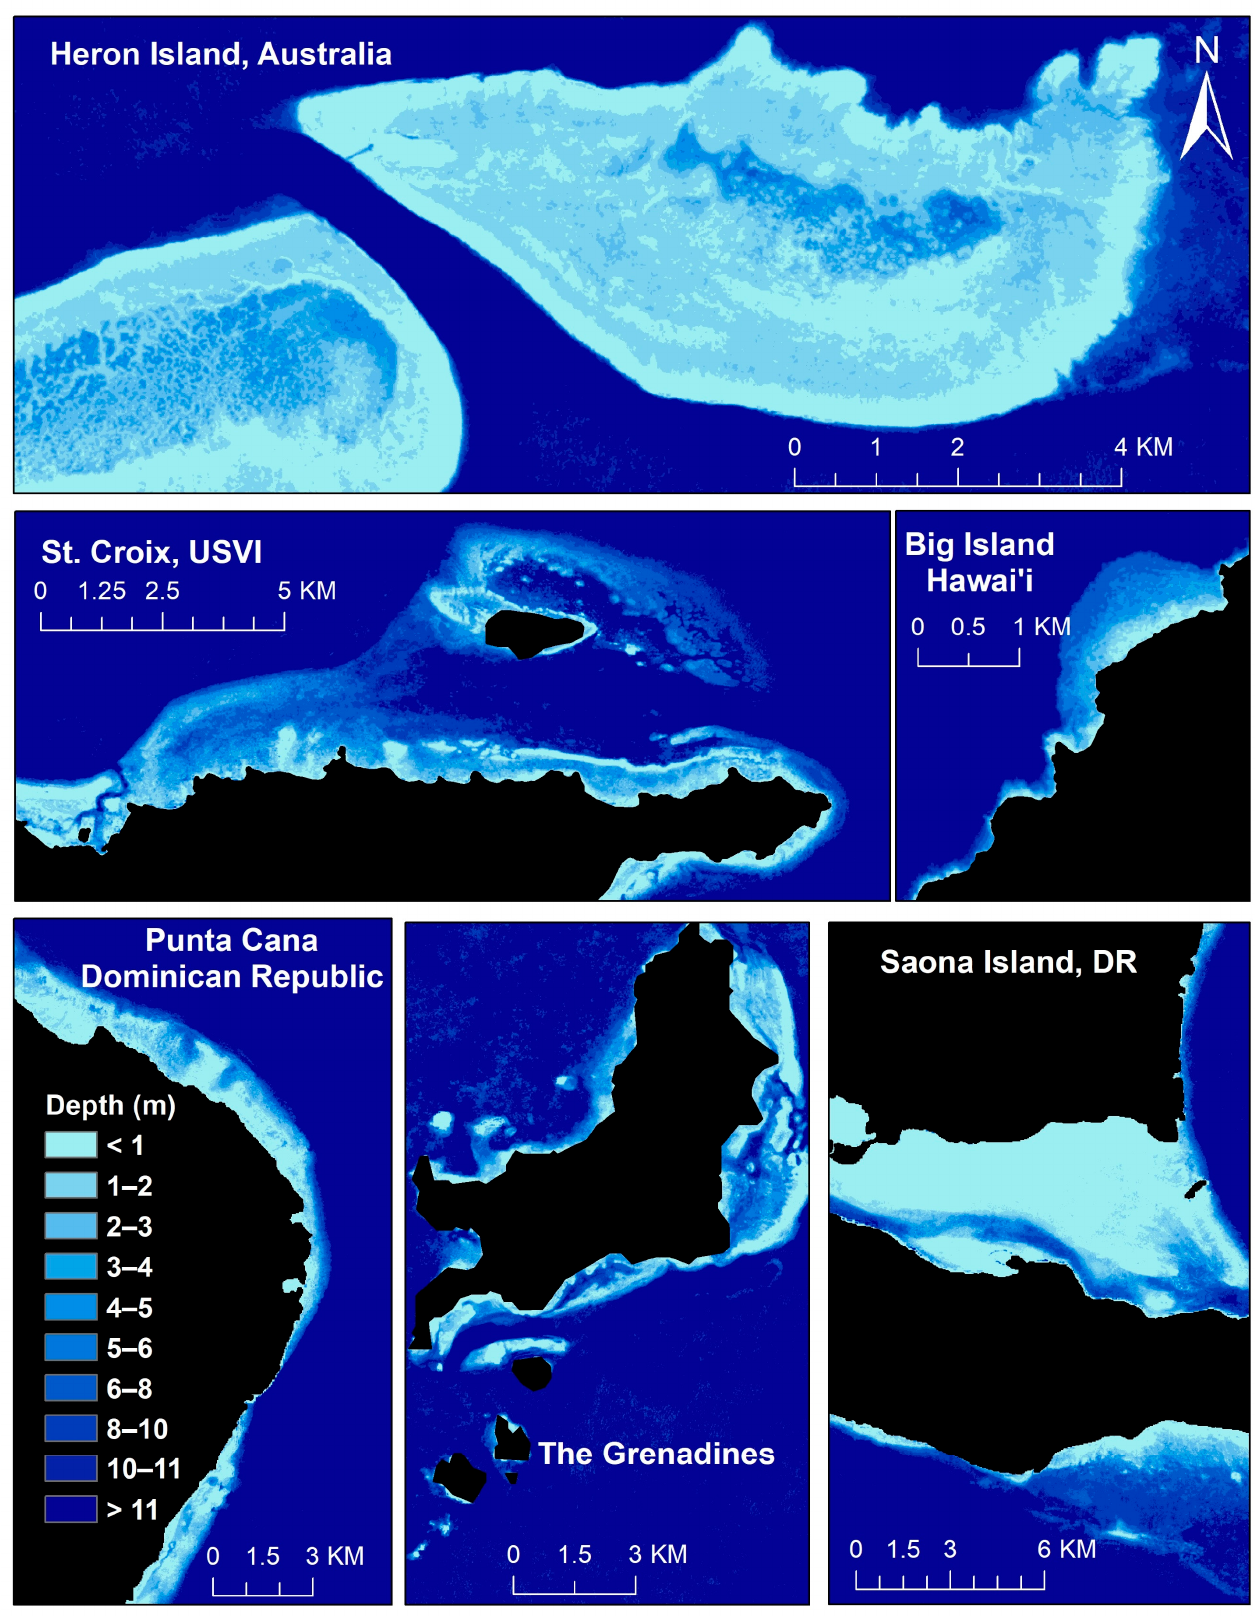
Figure 5. Spatial variations of shallow bathymetry models within the six study sites created using 12-month mosaics. The bathymetry represents the spatial variation of the benthic geomorphology.